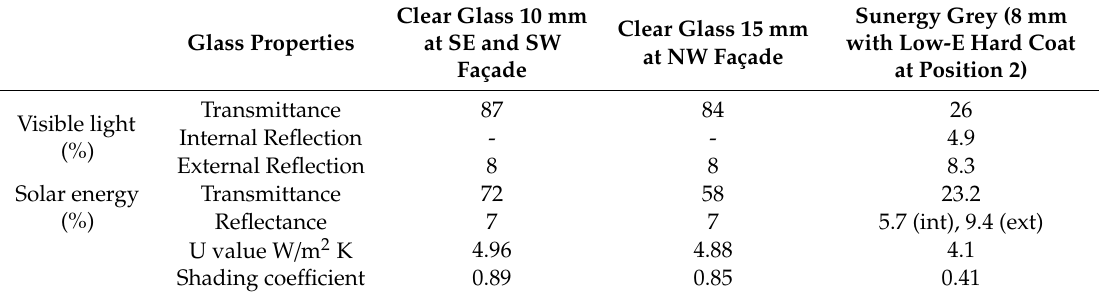
Table 2. Properties of glass